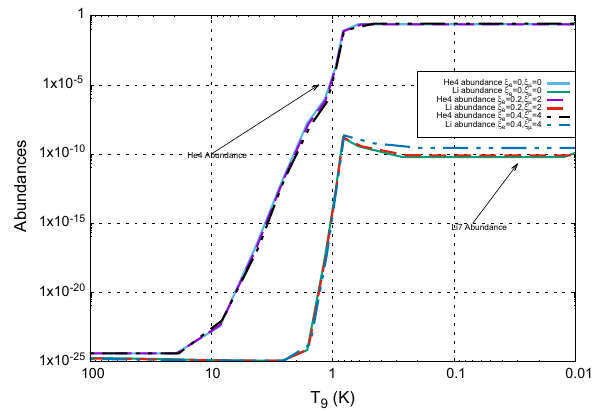
Fig. 6 Comparisonofabundancesinthepresenceandabsenceofinho- mogeneities for muon degeneracy greater than the electron degeneracy